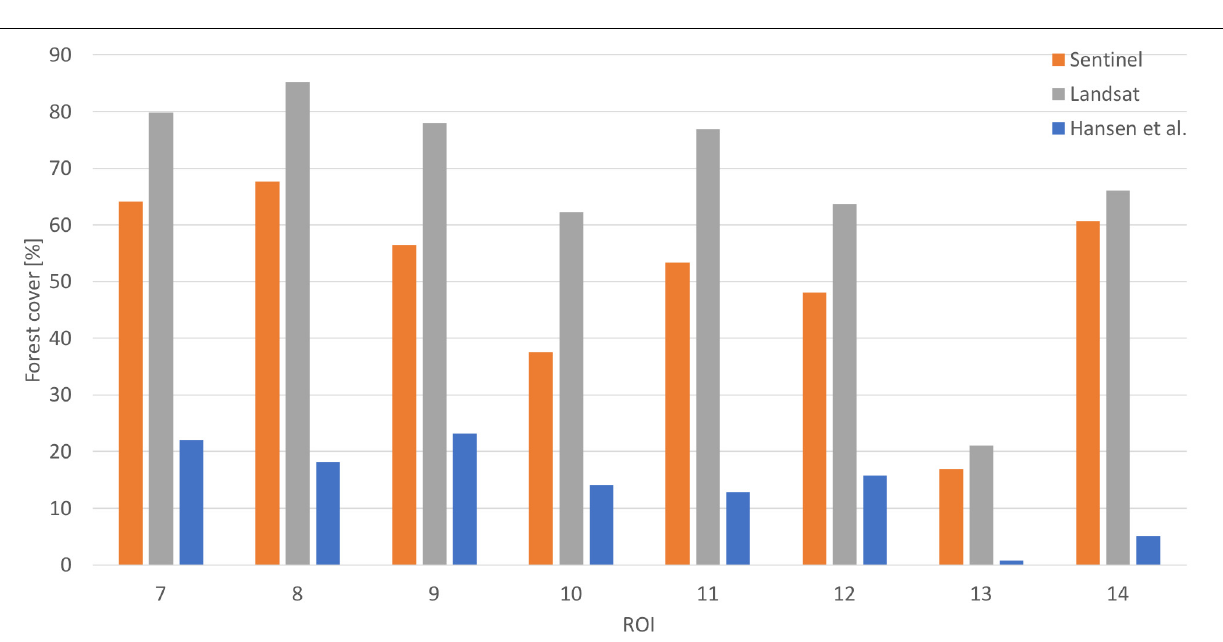
FIGURE 10 | Comparison of forest cover for Sentinel-2a, Landsat 7, and Global Forest Change data [(“Global Forest Change” n.d.; Hansen et al., 2013) for